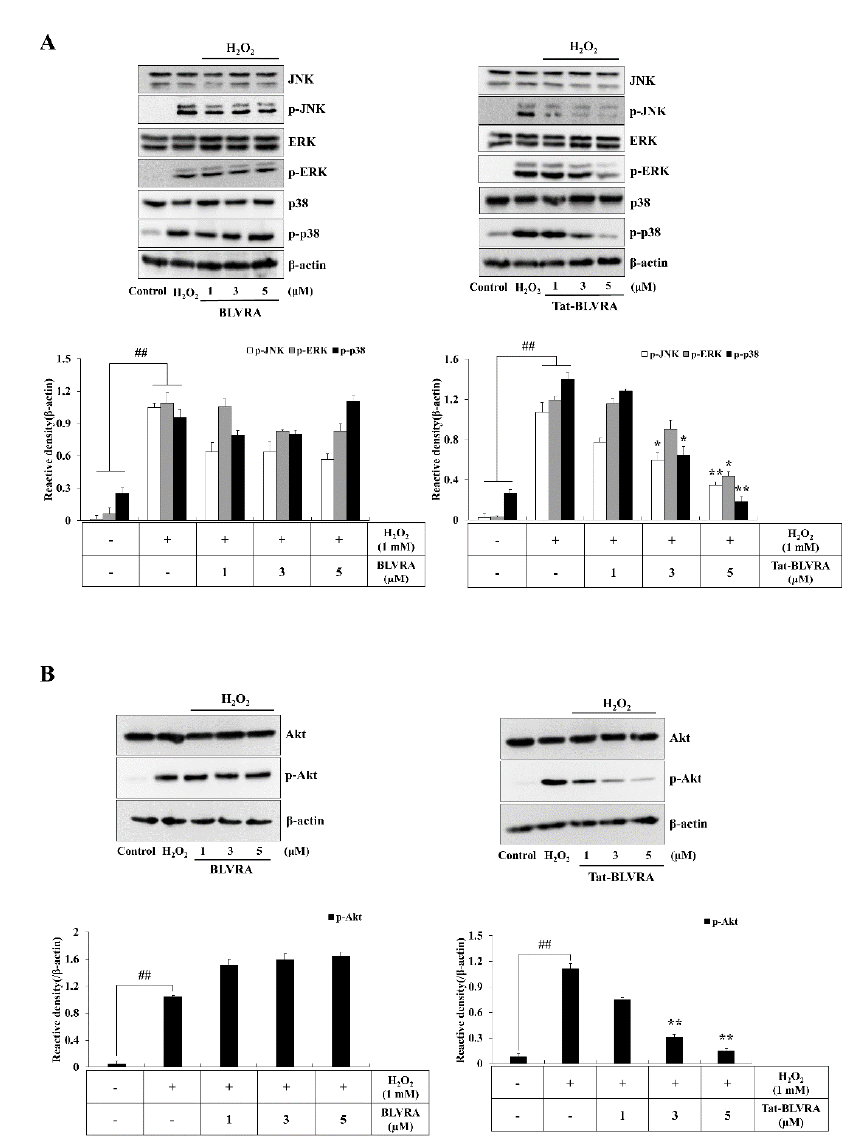
Figure 5. Effect of Tat-BLVRA protein on the activation of MAPK ( A ) and protein kinase B (Akt) ( B ) in HT-22 cells. The cells were treated with Tat-BLVRA protein and then exposed to H 2 O 2 . The activation of MAPK and Akt levels were measured by Western blotting and band intensity was measured by a densitometer. The bars in the figures represent the mean ± SEM obtained from 3 independent experiments. * p < 0.05 and ** p < 0.01 compared to cells treated only with H 2 O 2 . ## p < 0.01 compared to the untreated control cells.